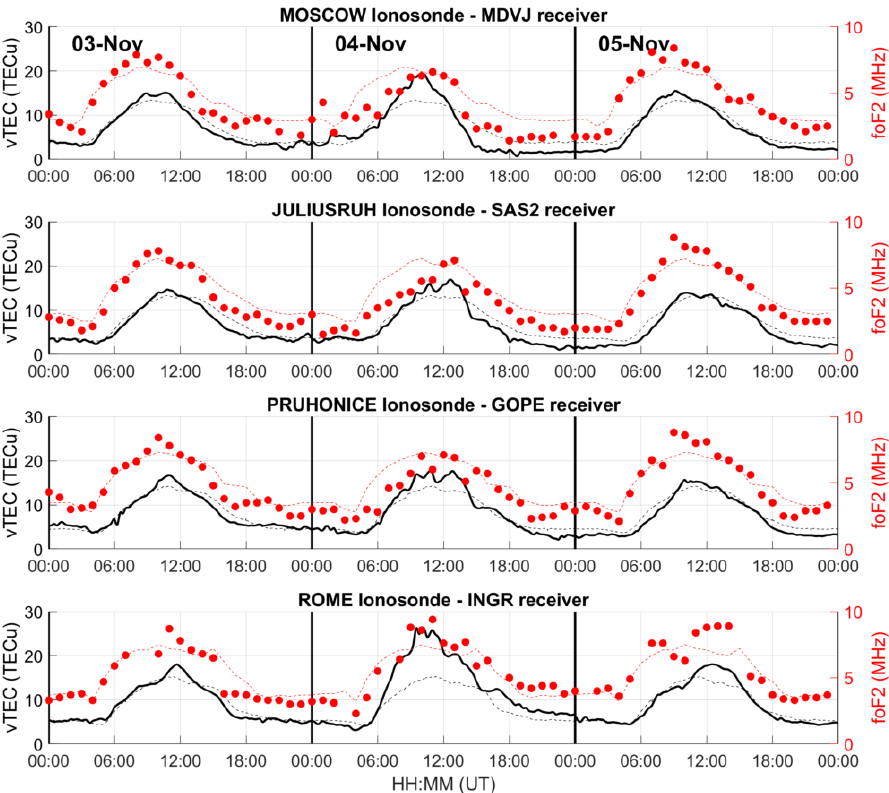
Figure 5. Time profiles of vTEC (black curve) and foF2 (red dots) for the considered couples ionosondes–GNSS receiver, during 3–5 November 2021. The black and red dashed lines repre- sent the corresponding median values evaluated in the 27 days preceding 3 November 2021, and here used as the quiet